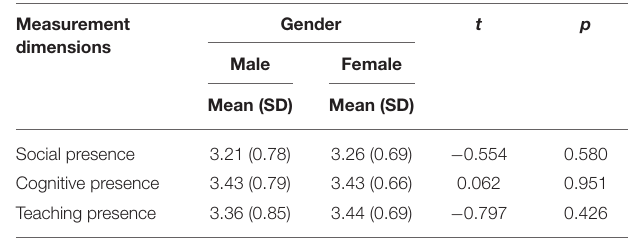
TABLE 4 | The heterotrait–monotrait (HTMT) ratio of the correlations.